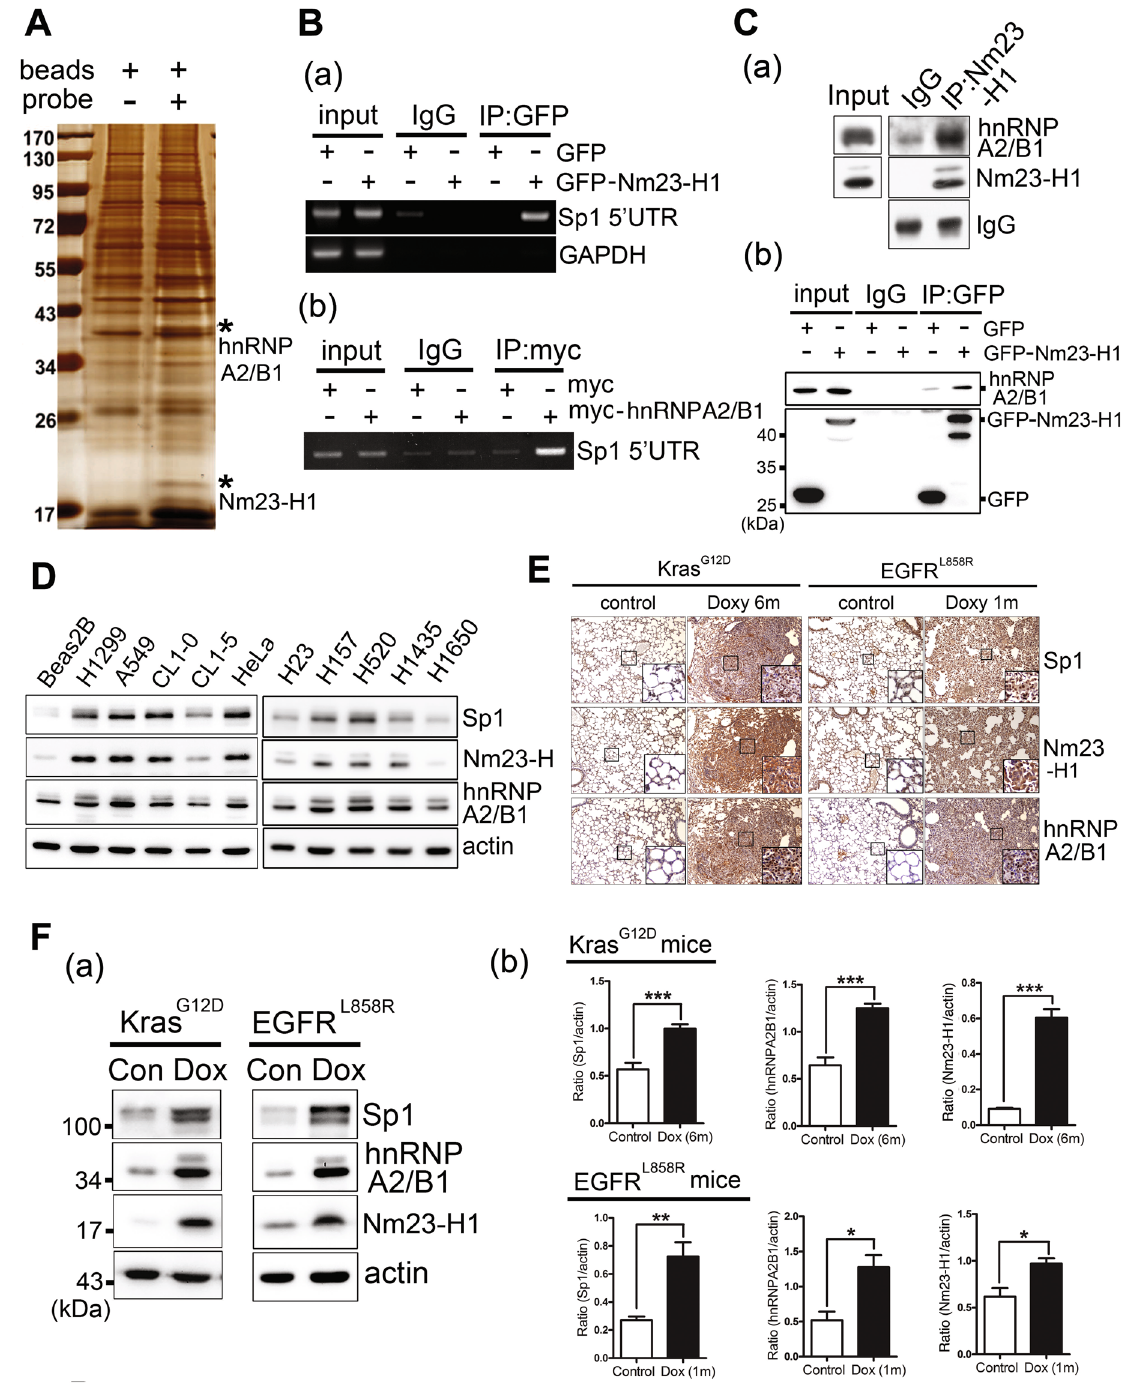
Figure 1. Nm23-H1 and hnRNPA2/B1 overexpressed in lung cancer are recruited to the 5 ′ -UTR of Sp1 mRNA. ( A ) In vitro transcribed pGEM-Sp1-5 ′ -UTR RNA was used as a probe and was incubated with the total cell lysates of HeLa cells. The pulldown mixtures were analyzed using sliver staining and LC MS/MS. ( B ) Samples were harvested from cells with GFP-Nm23-H1 or myc-hnRNPA2/B1 overexpression for IP with antibodies against GFP or myc. RNA fragments were isolated from IP samples for RT-PCR. ( C ) Samples were collected from cells with GFP or GFP-Nm23-H1 expression for IP with anti-Nm23-H1 (a) or anti-GFP (b). IP samples were analyzed by Western blotting with antibodies against the indicated proteins. ( D ) The levels of Sp1, Nm23- H1and hnRNPA2/B1 in the various cancer cell lines were studied by Western blotting with antibodies against indicated proteins. ( E , F ) The levels of Sp1, Nm23-H1and hnRNPA2/B1 in mice with Kras G12D - and EGFR L858R - induced lung cancer were studied using IHC staining ( E ) and Western blotting ( F ). After three independent experiments, the levels were quantified and statistically analyzed with t-test, * p < 0.05; ** p < 0.01; *** p <